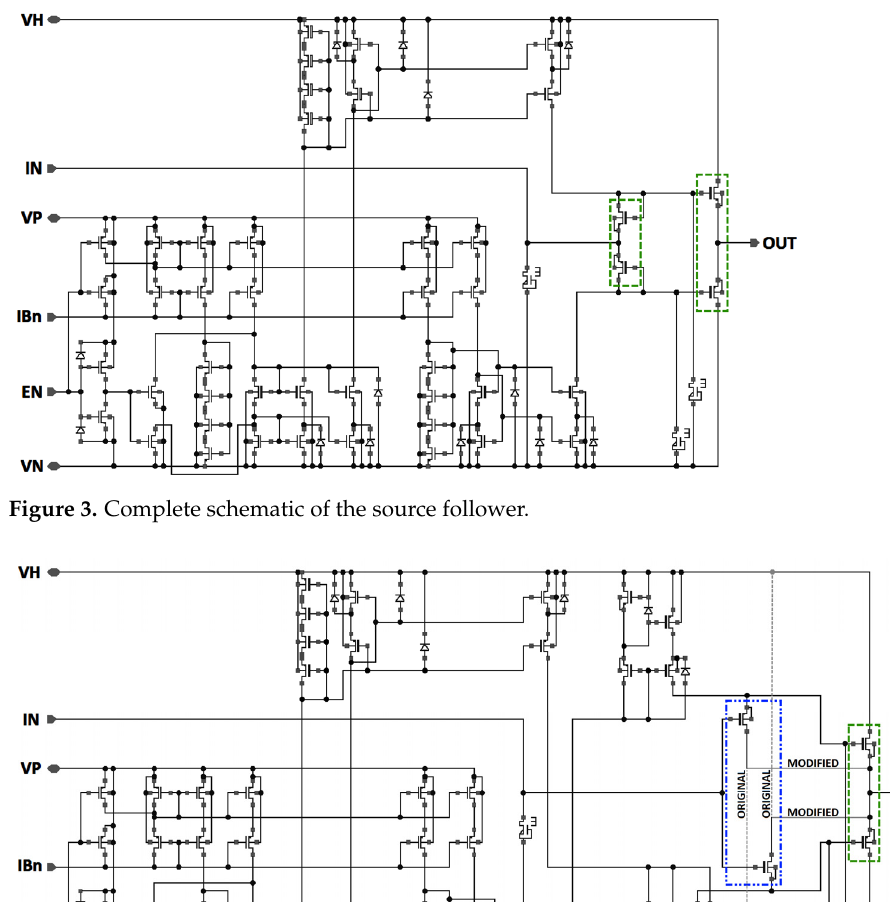
Figure 2. Two versions of the buffer equipped with sets of small resistors: ( a ) for higher gate source voltages of medium/high-voltage MOS transistors; ( b ) for the opposite case [1].